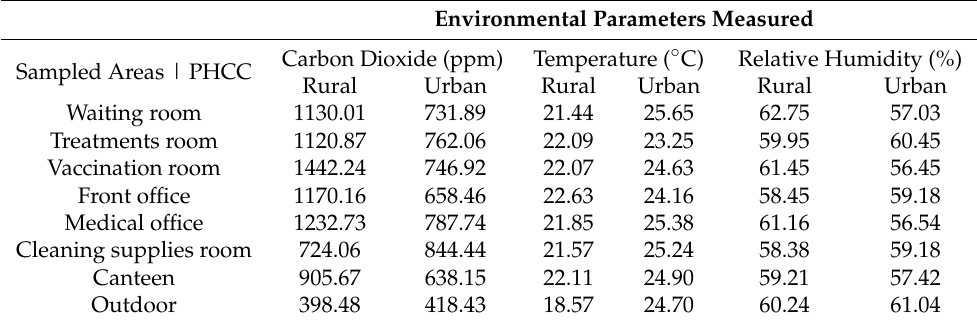
Table 2. Environmental parameters